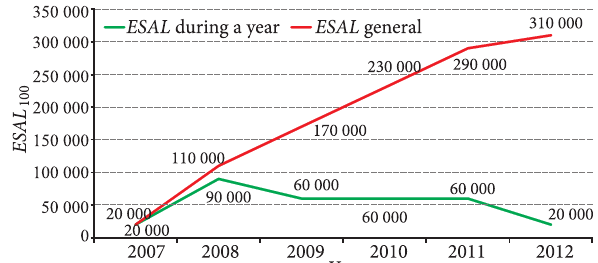
fig. 2. Change in ESAL 100 during the experiment